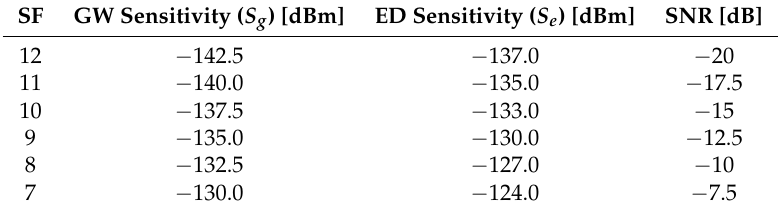
Table 1. Sensitivity and required signal-to-noise ratio (SNR) of EDs and GW with 125-kHz mode